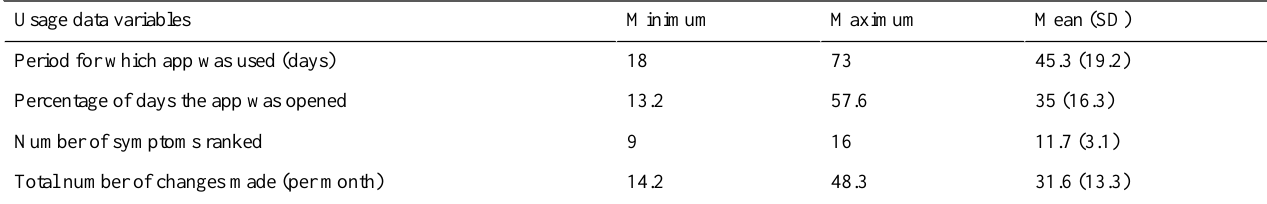
Table 2. App-derived usage